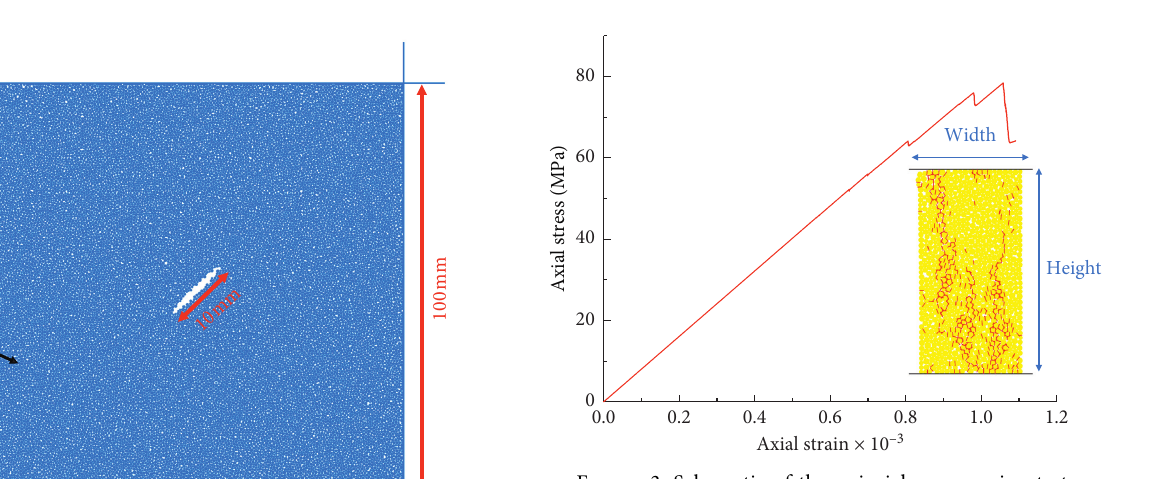
Figure 3: Schematic of the uniaxial compression test.